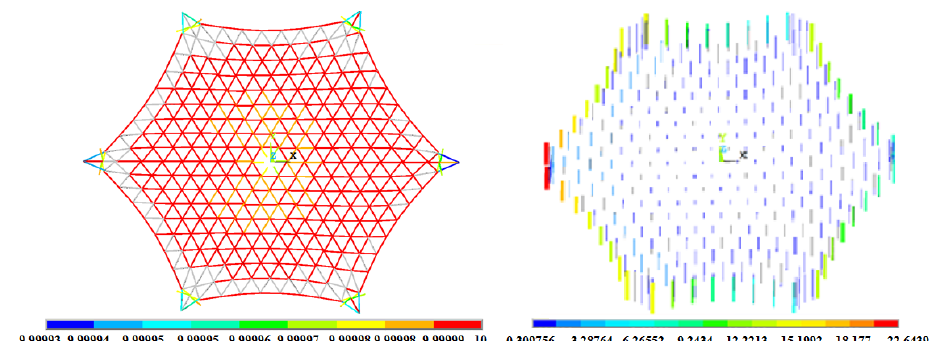
Fig. 6. Node displacements in the FEM of frontal (rear) cables, m